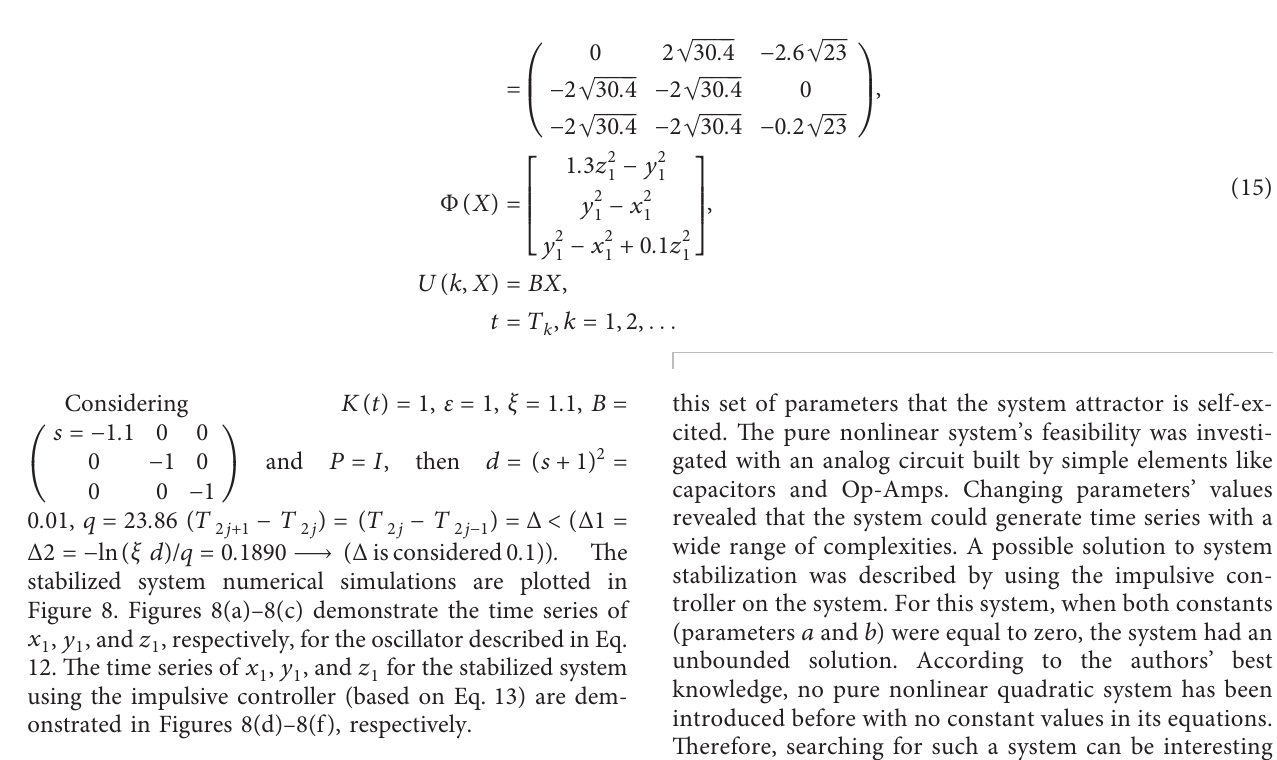
Figure 8: For the initial condition ( 0 . 1 , 0 . 1 , 0 . 1 ) , time series of x (b), and (c), respectively. The transient signals of, x (d), (e), and (f),